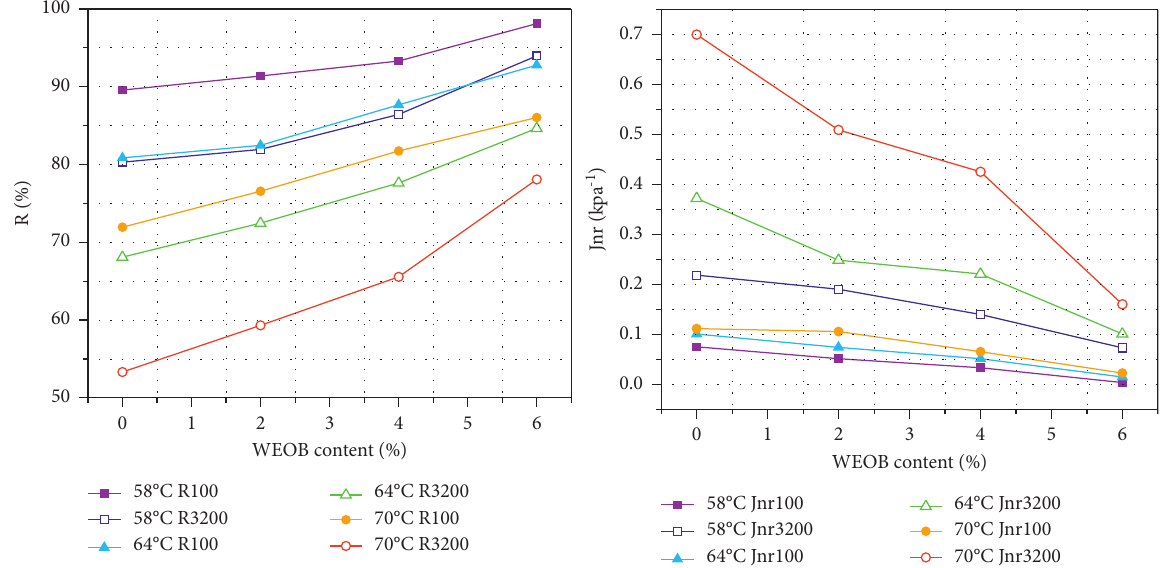
Figure 8: R (a) and J (b) for WEOB/SBS-modified binders at various temperatures.